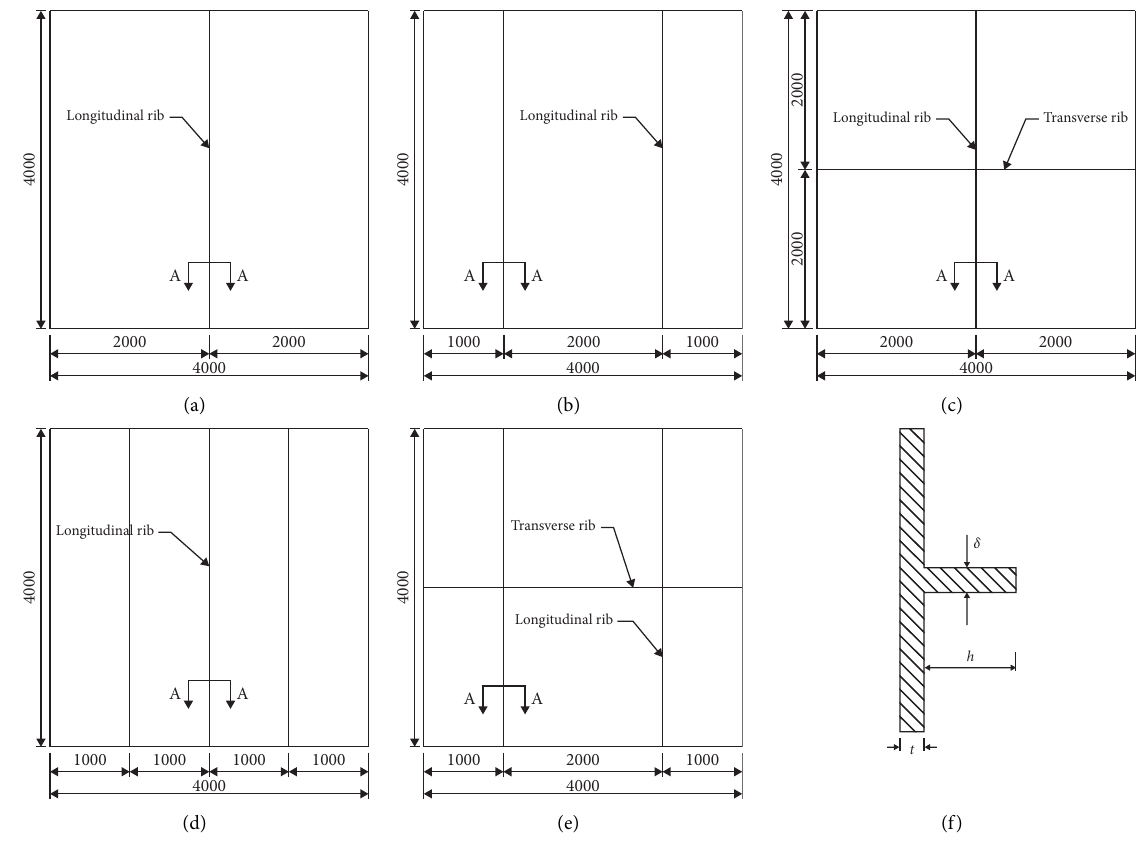
Figure 4: Reinforced flat blast-resistant door (RFBD; unit: mm): (a) one longitudinal rib (RFBD1), (b) two longitudinal ribs (RFBD2), (c) one longitudinal rib and one transverse rib (RFBD3), (d) three longitudinal ribs (RFBD4), (e) two longitudinal ribs and one transverse rib (RFBD5), and (f) section A-A.